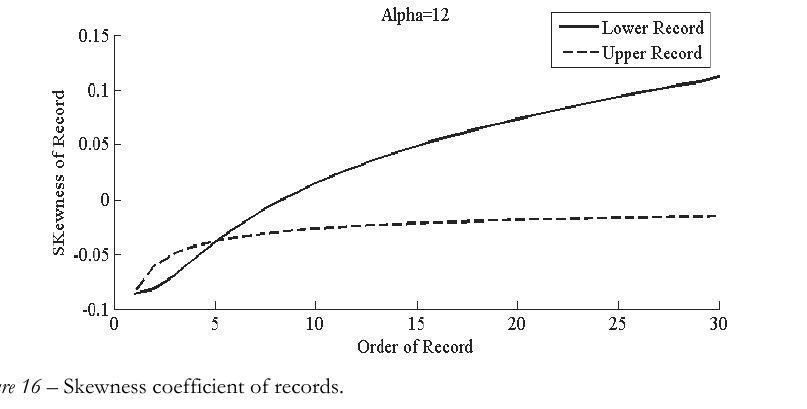
Figure 16 – Skewness coefficient of records.